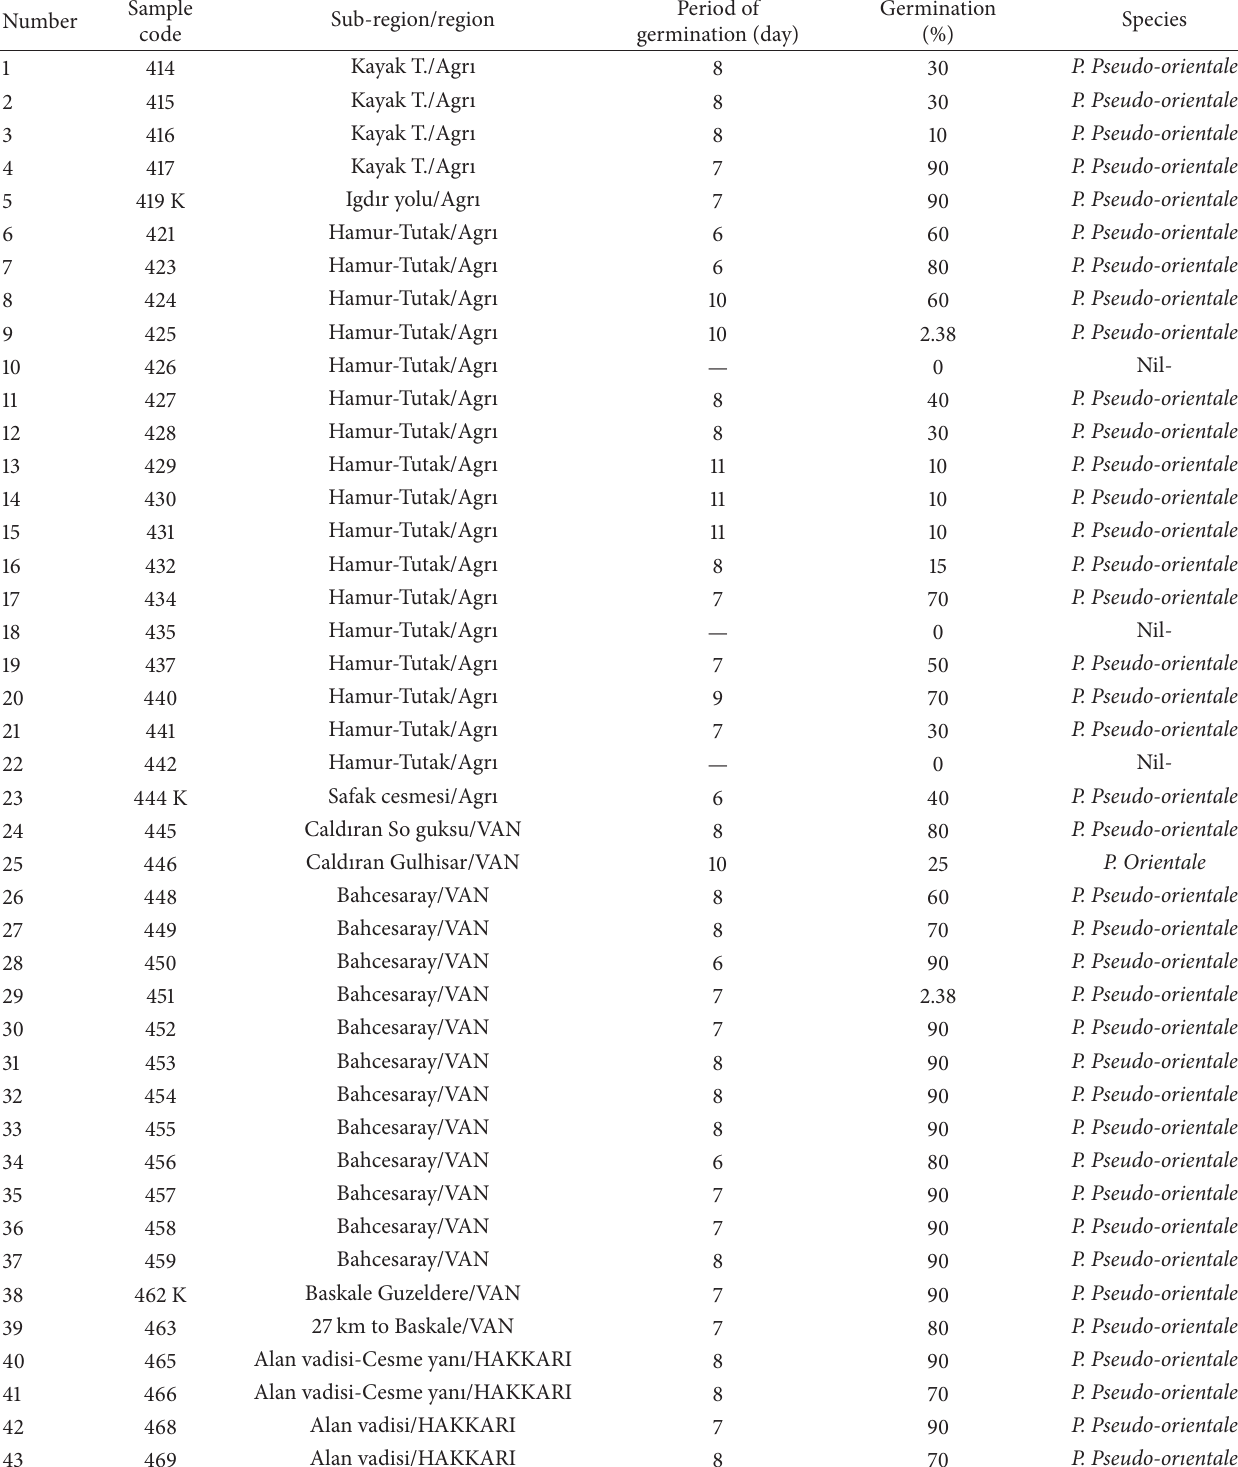
Table 1: Sample code, sub region/region, number of days to germinate seeds, germination percentage, and the identified Papaver species from the samples collected from various regions of Turkey and